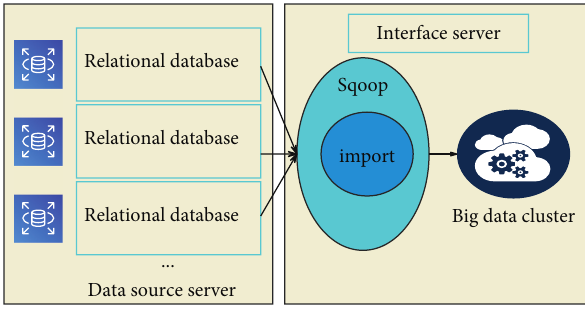
Figure 7: The design idea of Sqoop data